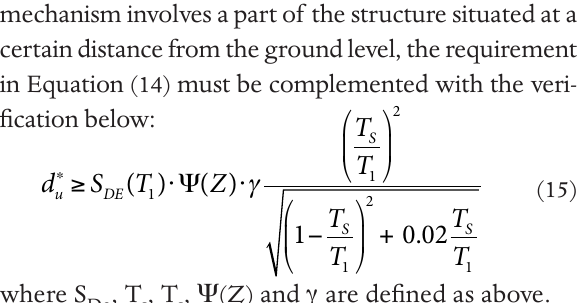
is the displacement seismic demand; and SF is the safety factor). d